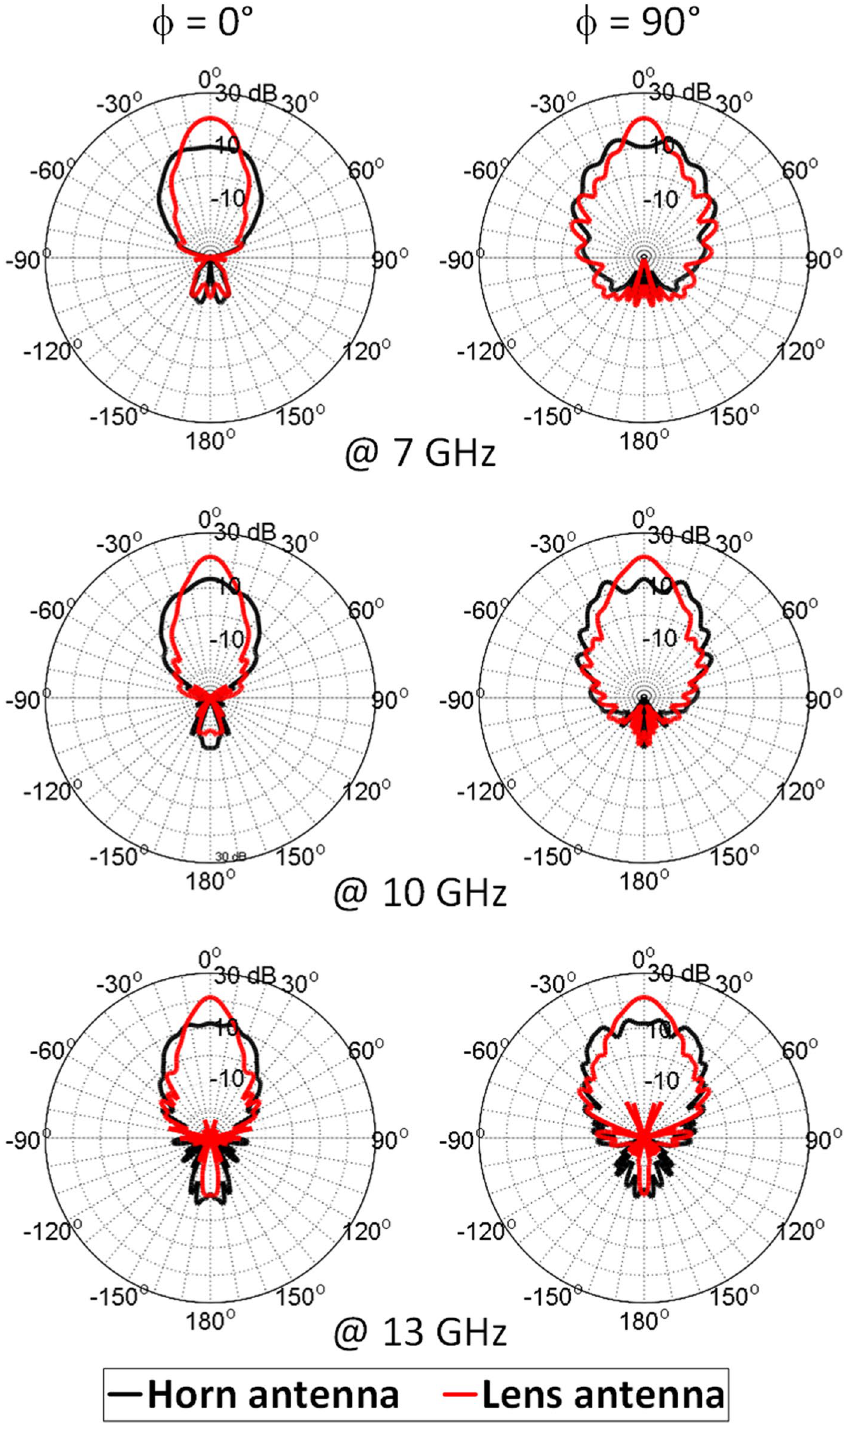
Figure 8. Simulated electric far field distribution of the conical horn antenna alone and the horn antenna with the 3D discrete lens in the x-y plane at 7 GHz, 10 GHz and 13